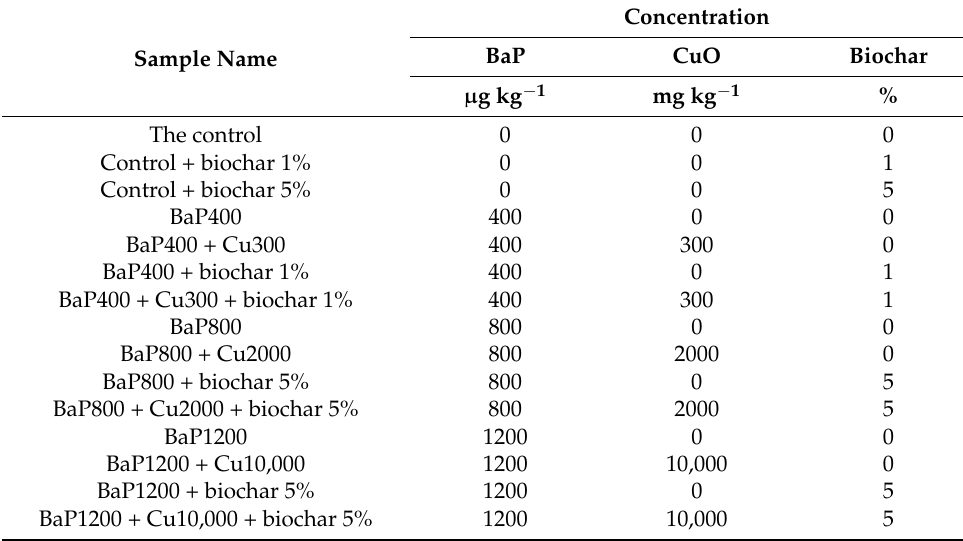
Table 2. Scheme of a model experiment with barley and